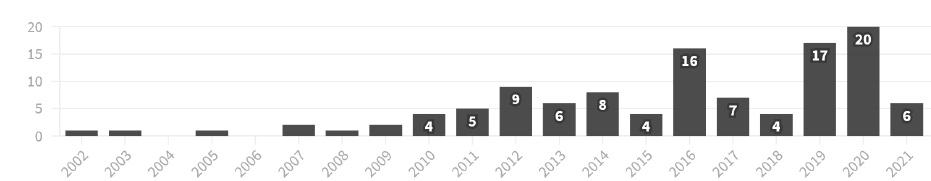
Figure 4. Distribution of the selected references by publication year.